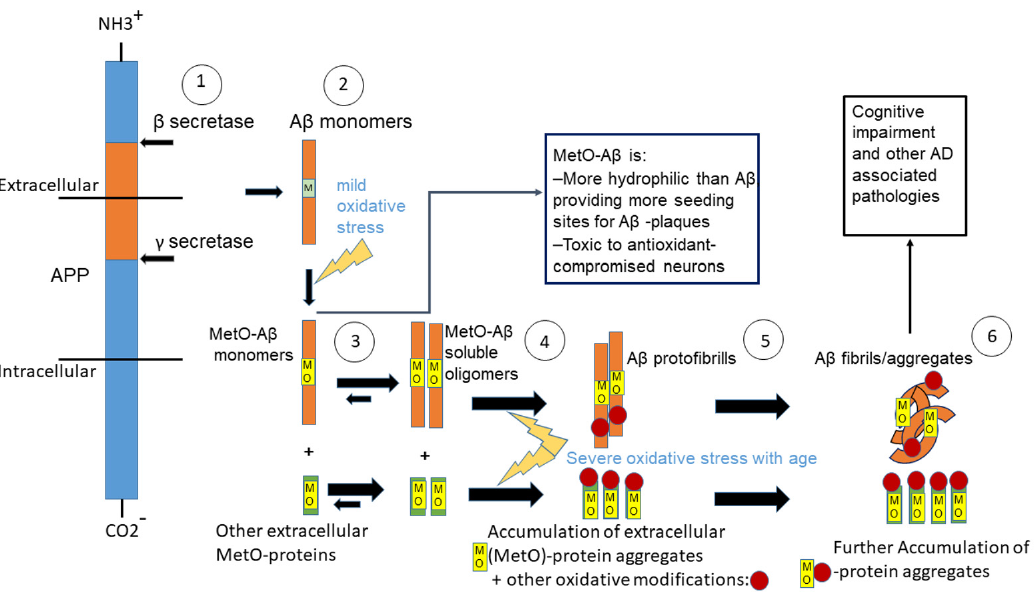
Figure 1. A graphical summary of the proposed events leading to MetO-A β and MetO-protein mediated toxicity in Alzheimer’s disease brain.